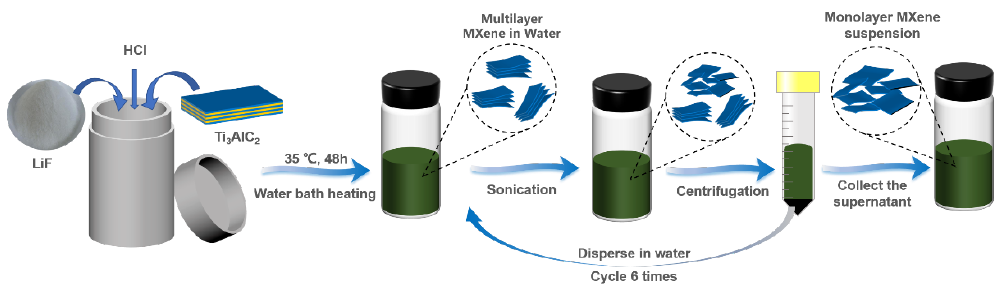
Figure 1. Process Flow Diagram of CU-CS.